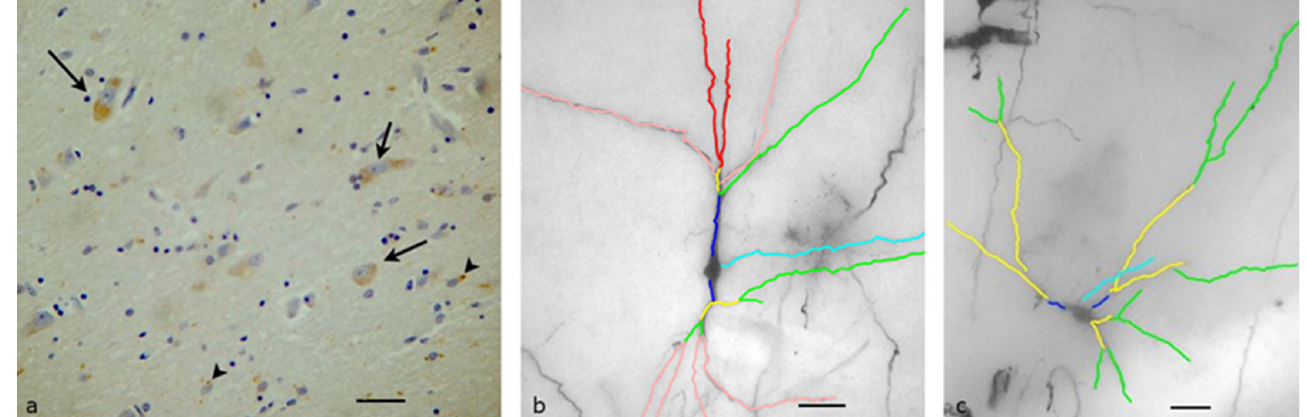
Figure 5. Supraoptic Nucleus of the human Hypothalamus: ( a ) Immunohistochemical staining specific for OX1R. SI neurons are more immunopositive (black arrow) than SII neurons, which have mild cytoplasmic staining, in the form of small deposits (arrow heads) (Scale bar, 30 μ m); ( b ) A Golgi-stained SI neuron mapped by the ImageJ program. Primary (dark blue), secondary (yellow), tertiary (green), quaternary (pink) and even quinary (red) dendrites can be found. As such, SI neu- rons have some of the most complicated dendritic trees in the human hypothalamus. Light blue depicts the axon of the neuron (Scale bar, 30 μ m); ( c ) A Golgi-stained SII neuron mapped by the ImageJ program. Primary (dark blue), secondary (yellow) and tertiary (green) dendrites can be found. Light blue depicts the axon of the neuron. SII neurons are smaller and have a simple dendritic tree (Scale bar, 20 μ m).